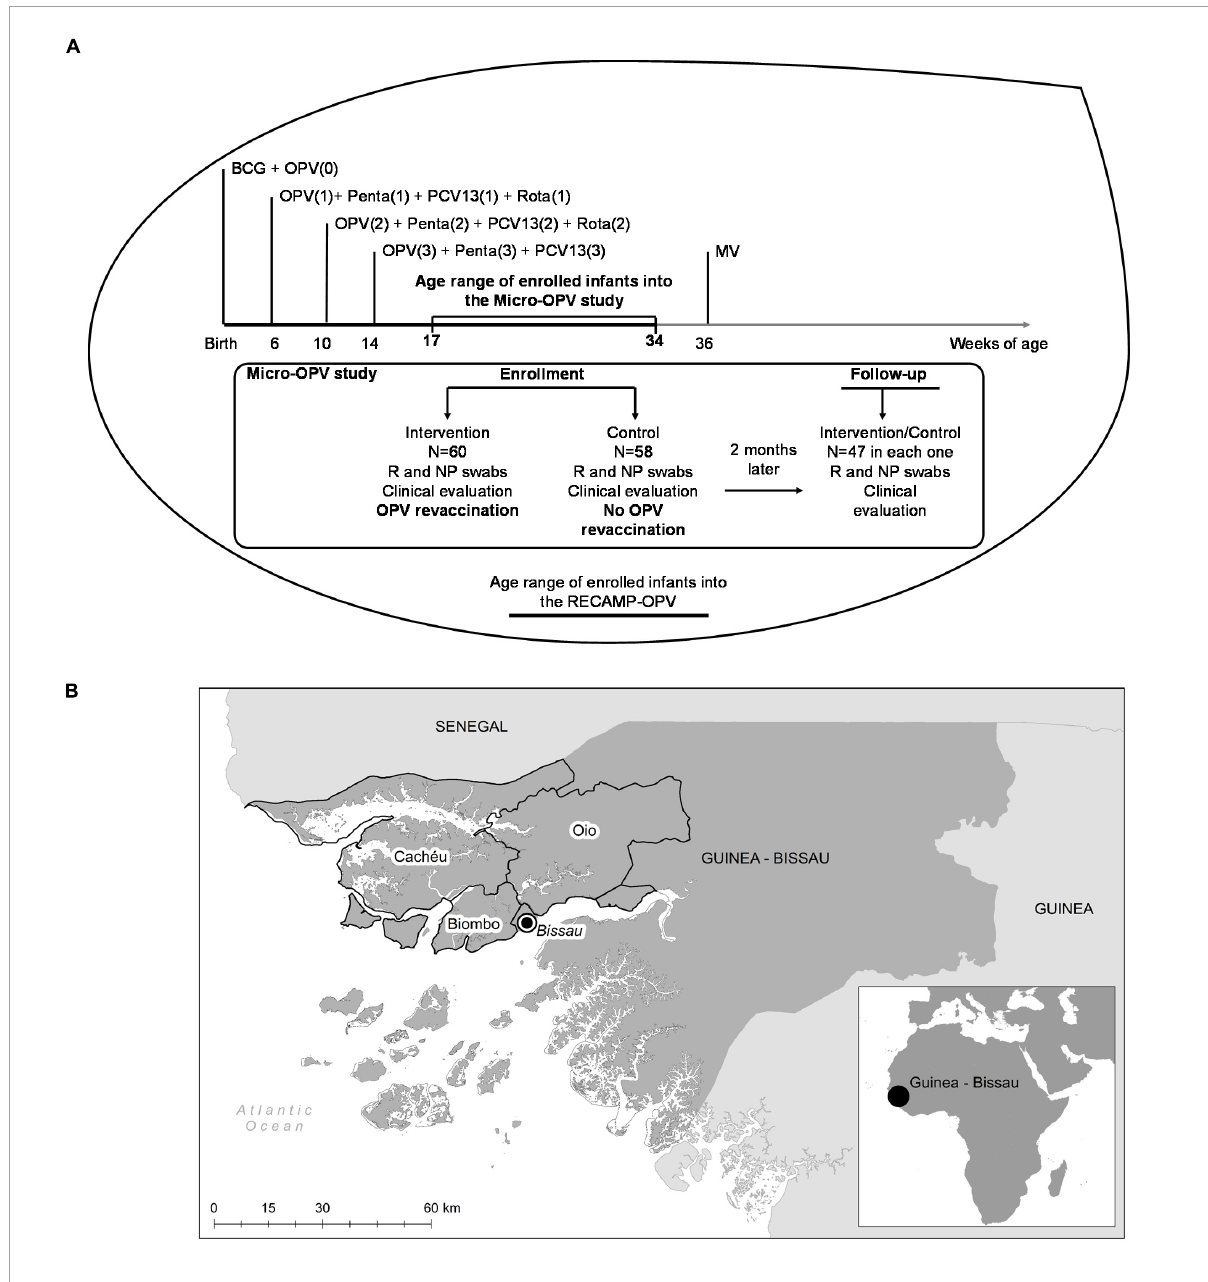
FIGURE1 Experimental design and settings of the Micro-oral polio vaccine (OPV) study. (A) The Micro-OPV is a cohort study within a large cluster randomized clinical trial, the RECAMP-OPV. At enrollment, infants were clinically evaluated, and submitted to the collection of biological samples and, infants enrolled into the Intervention clusters were revaccinated with OPV, whilst infants enrolled into the Control clusters received no OPV revaccination. Two months later, 47 infants in each group were clinically evaluated and submitted to a new collection of biological samples. Vaccines such as Bacillus Calmette-Guérin (BCG), OPV, Pentavalent (DPT, HBV, Hib), PCV-13, Rotavirus, and measles vaccine (MV) are given as indicated as part of the national routine immunization plan. (B) Guinea-Bissau is on the west coast of Sub-Saharan Africa, as shown in the small picture at the bottom right corner. The villages participating in the Micro-OPV study, located in Cacheu, Biombo, and Oio highlighted regions, were within 2 h-drive from the capital